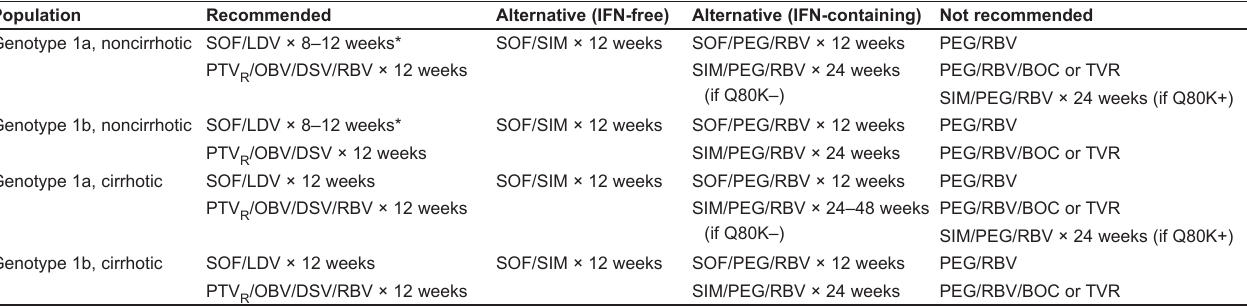
TABle 4 Treatment-naive patients with hepatitis C virus (HCV) genotype 1